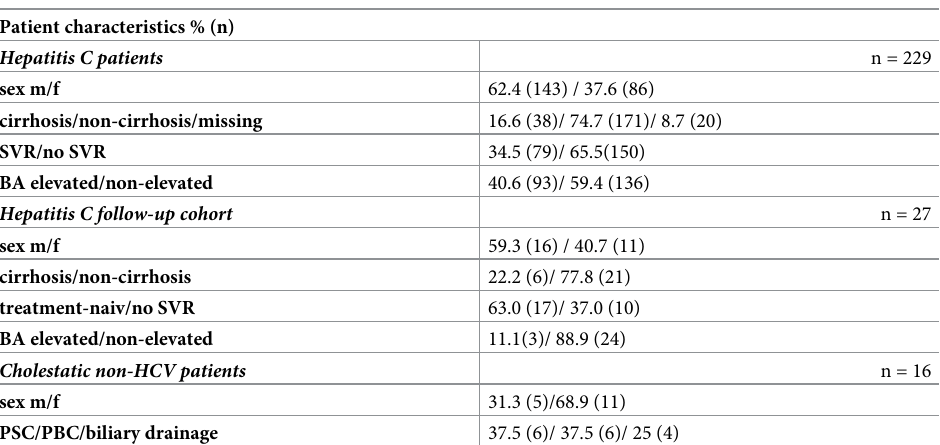
Table 1. Patient